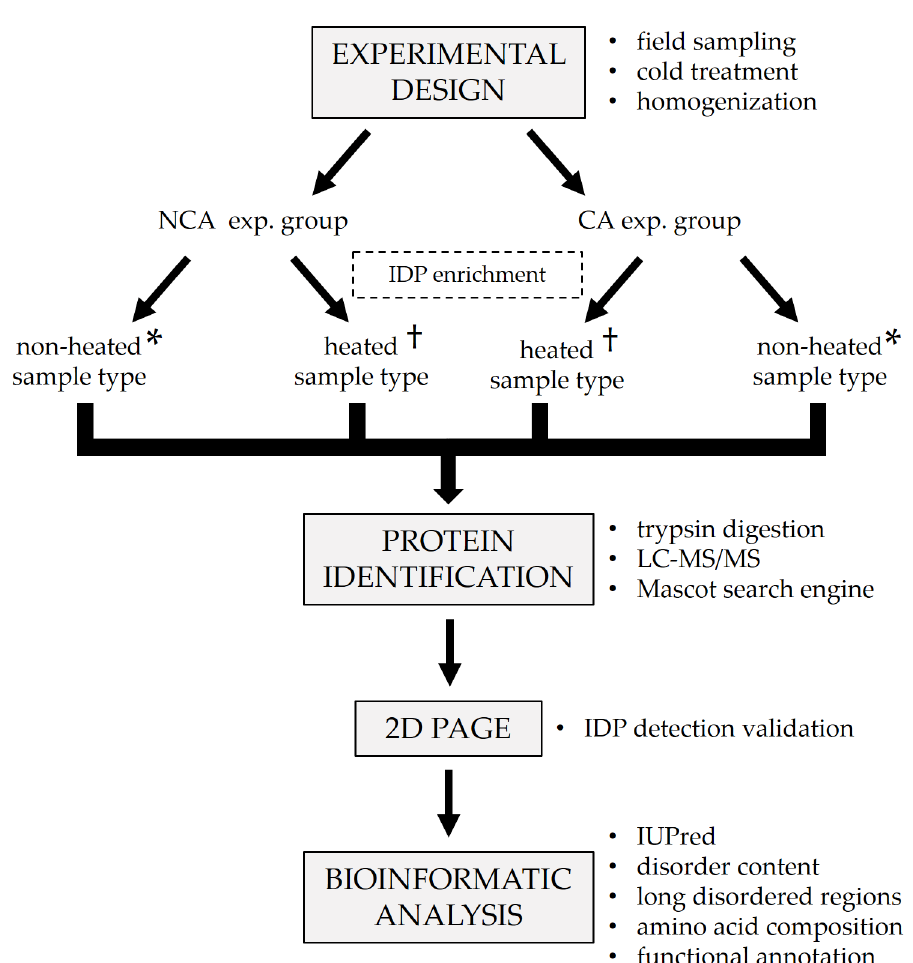
Figure 1. Generalized workflow of the experiment. Detailed explanations are given in the relevant subsections. Aliquots from samples with the same symbol in the superscript (* or †) were pooled before being run on 2D PAGE. NCA—non-cold-acclimated diapausing group; CA—cold-acclimated diapausing